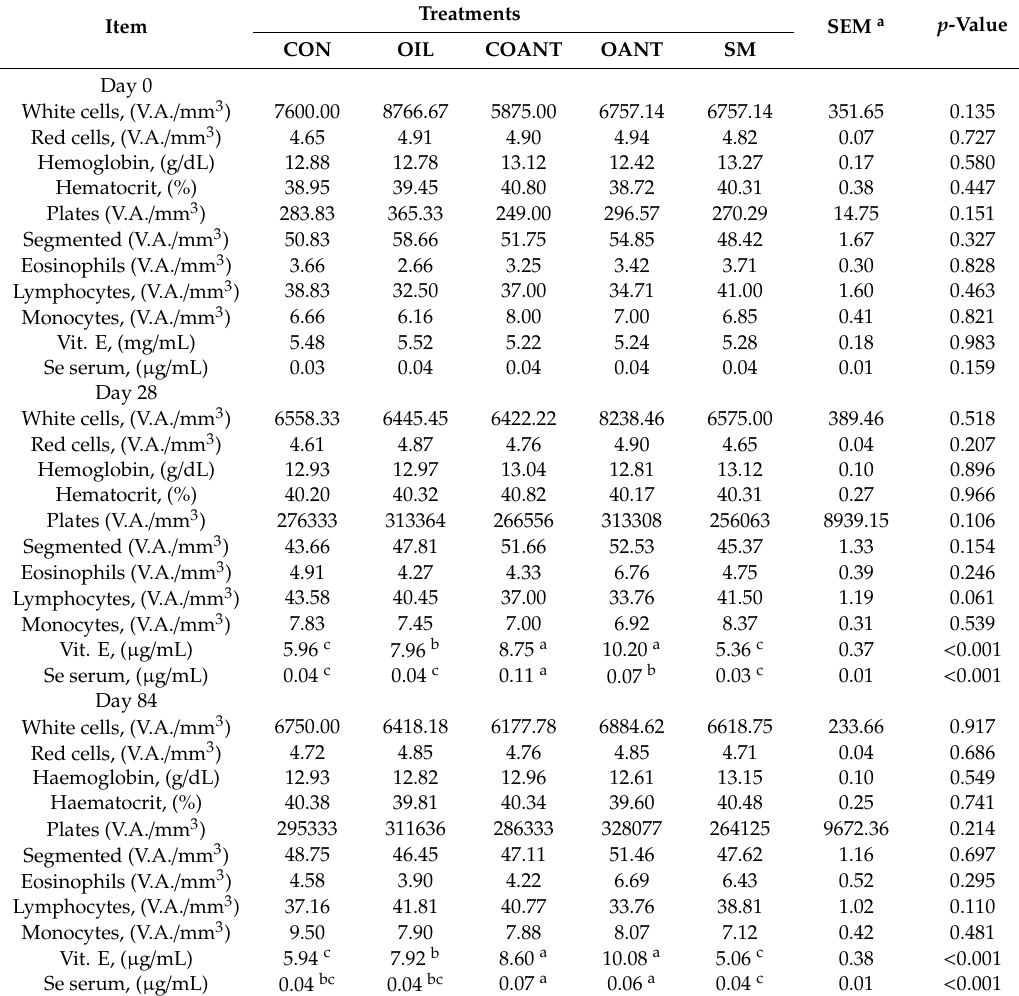
Table 2. Blood metabolites in children according to treatments and collection